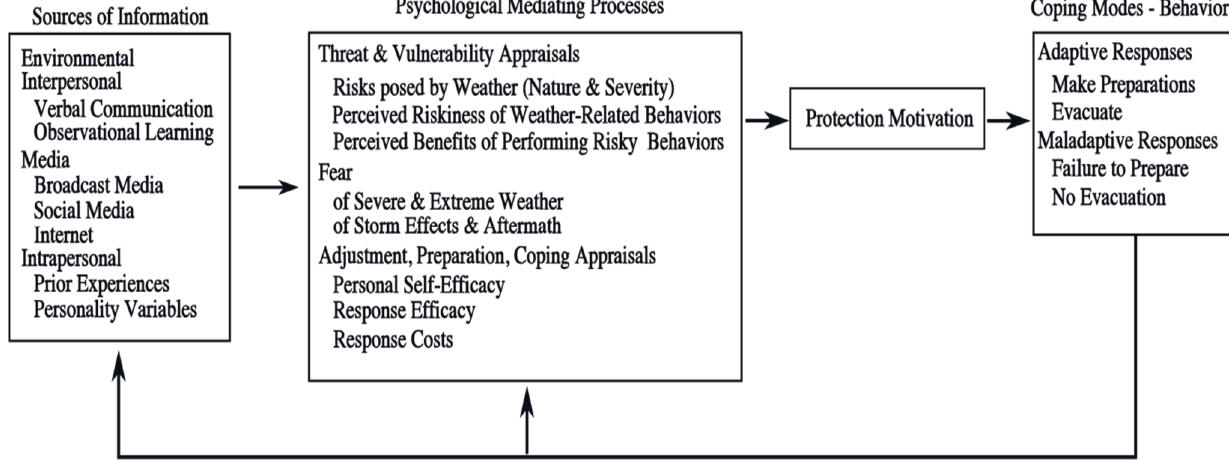
Figure 1. Protection Motivation Theory applied to the preparation and evacuation ahead of a hurricane. Adapted from Floyd, Prentice-Dunn, and Rogers [42], with permission from © 2000 John Wiley and